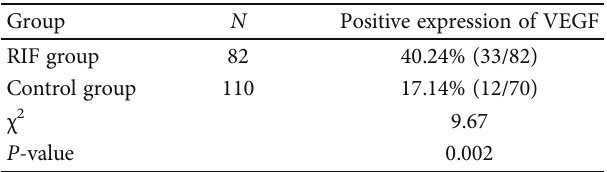
Table 2: Comparison of endometrial VEGF expression between the two patient